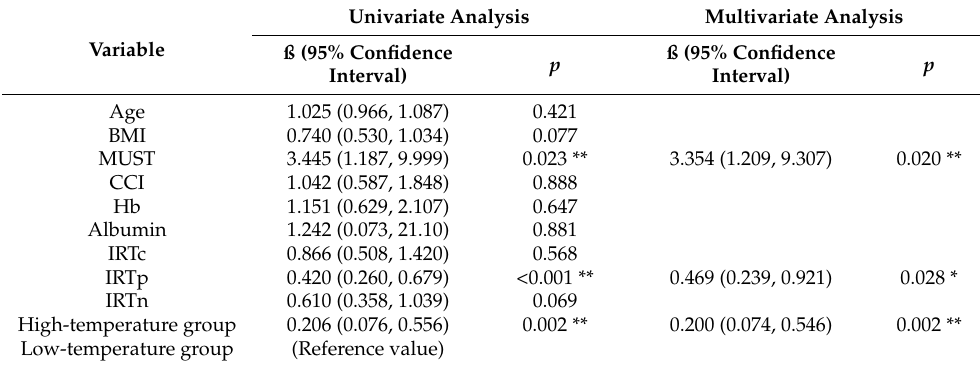
Table 3. Factors associated with poor wound-healing (increased PUSH score) after 1 day ( n = 248).